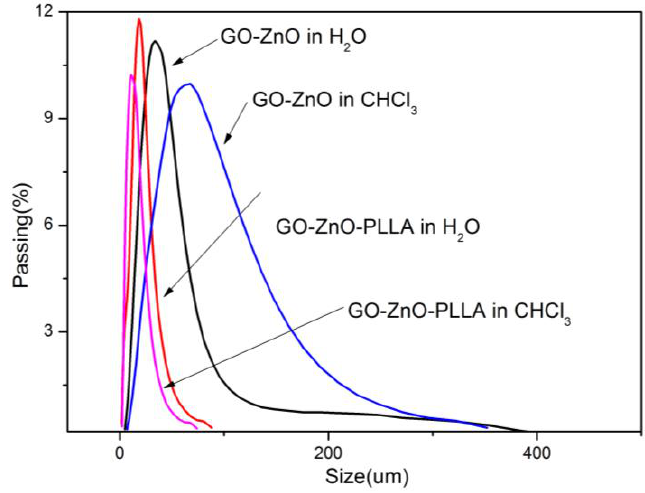
Figure 8. Laser analysis of particle size and shape of GO-ZnO and GO-ZnO-PLLA.